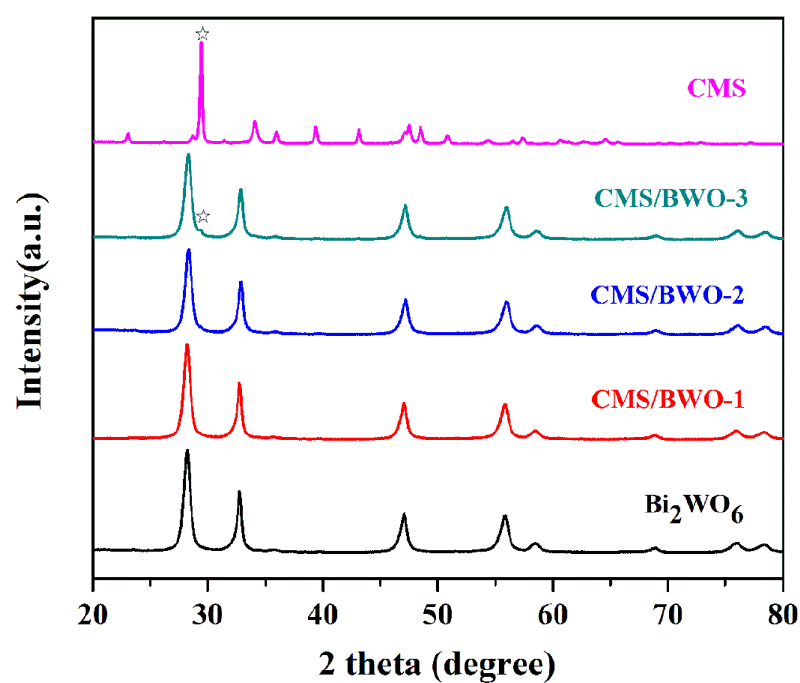
Figure 1. Powder X-ray diffraction (XRD) patterns of Bi 2 WO 6 , calcined mussel shells (CMS), and a series of Bi 2 WO 6 /calcined mussel shell (CMS/BWO-1, 2, 3) composites.